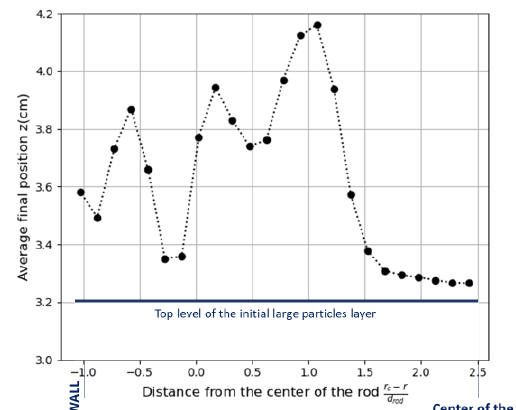
Fig. 5: Average vertical displacement field against normalized distance from the center of the rod after 4 revolutions (the top level of the layer of large particles was initially located at 3.2cm from the bottom of the vessel) – 𝑟 𝑐 being the radial coordinate of the center of the